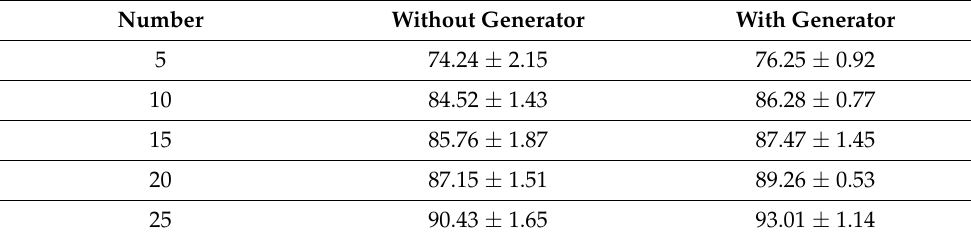
Figure 9. The classification maps for the KSC with compared methods. ( a ) Source Image. ( b ) Ground Truth. ( c ) SVM. ( d ) 2D-CNN. ( e ) 3D-CNN. ( f ) HSI-BERT. ( g ) CA-GAN. ( h ) DCFSL. ( i ) VSCNN. ( j ) S-DMM. ( k ) Our proposed method. ( l ) Legend. Table 14. The ablation experiments on Indian Pines (OA) (%).